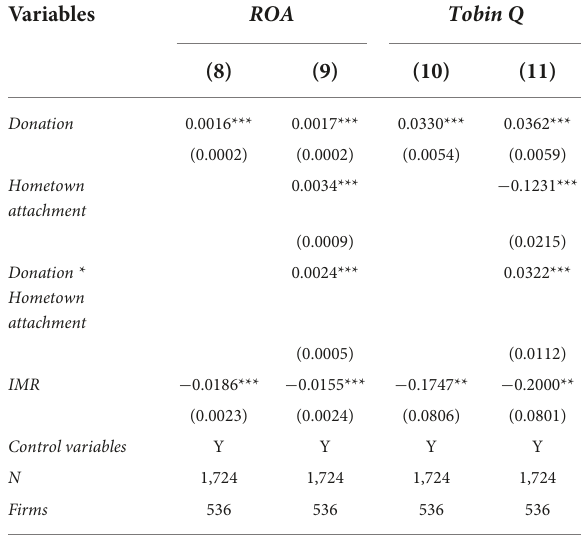
TABLE 10 Regression result of FGLS